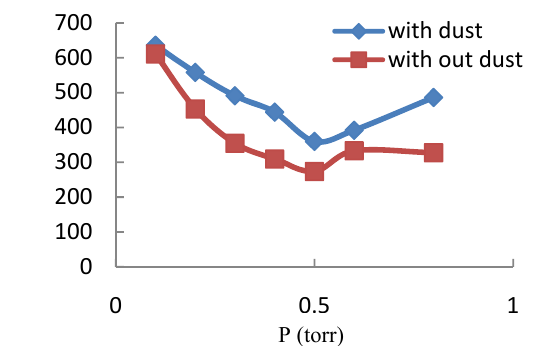
Fig.6: Schematic of the discharge voltage as a function of pressure at presence and absence ofdust